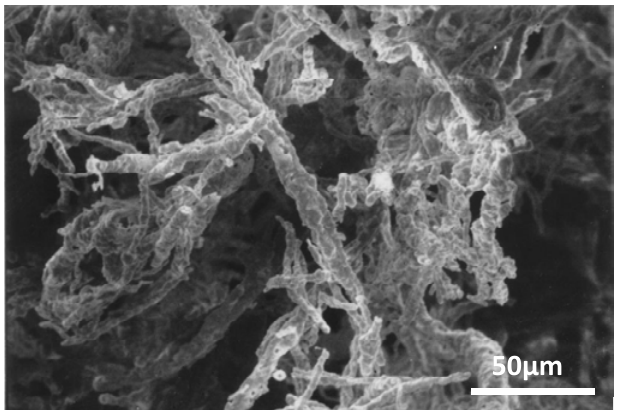
Figure 12. SEM photomicrograph of hydroxyapatite fibers incorporated into a polymer foam matrix. Reproduced from [57] with permission from